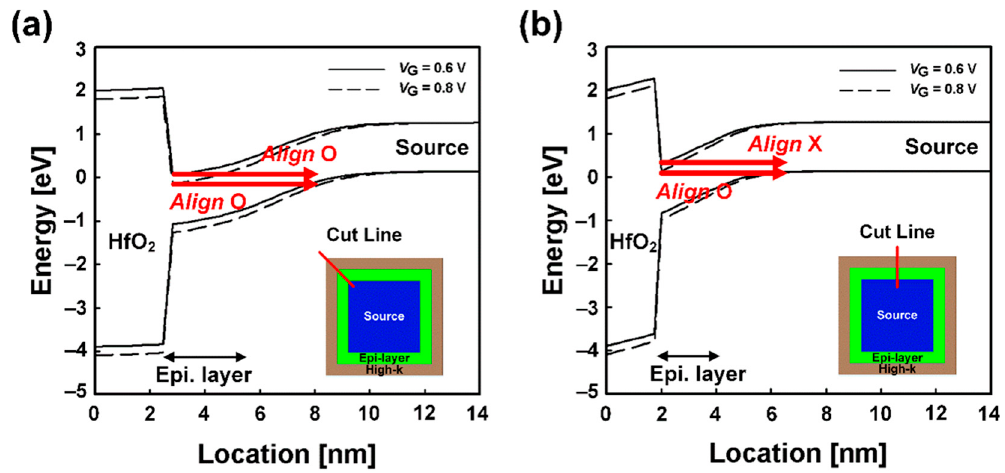
Figure 7. Energy band diagrams of the gate-normal NWTFETs extracted at the ( a ) corner and ( b )